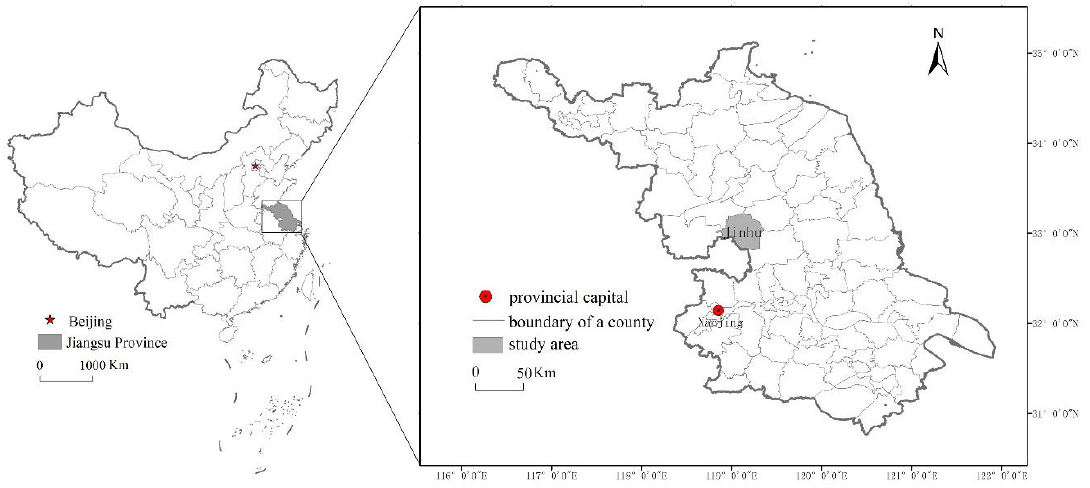
Figure 2. Location of the study area.